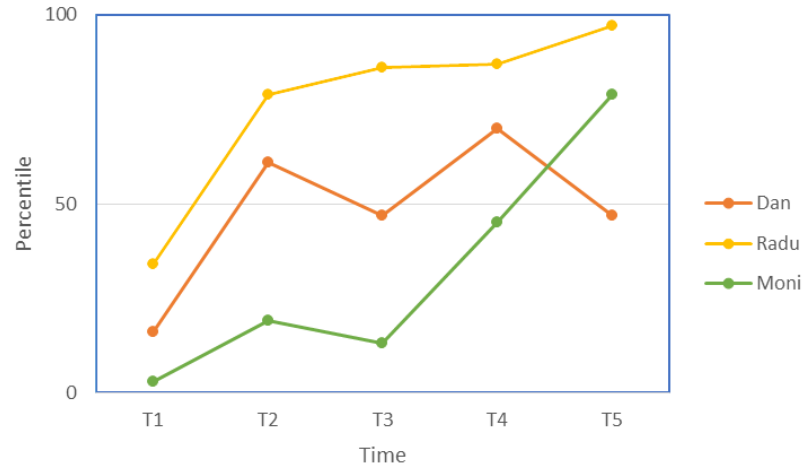
Figure 2. Peabody picture vocabulary test English percentile for each participant from T1 to T5.